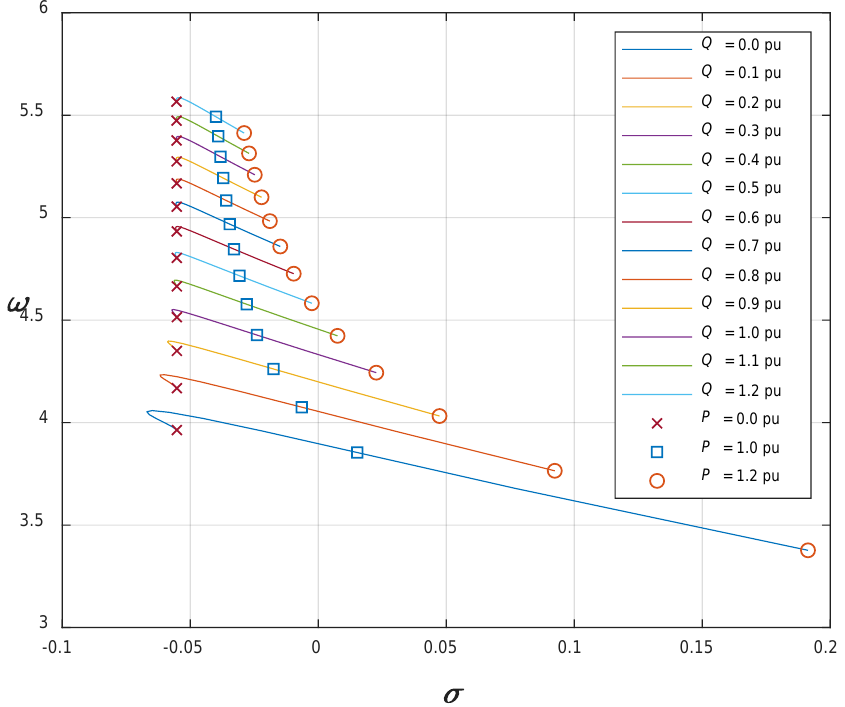
Figure 12. Eigenvalue loci of the local mode of 12-MVA hydro-type synchronous generator with AVR.